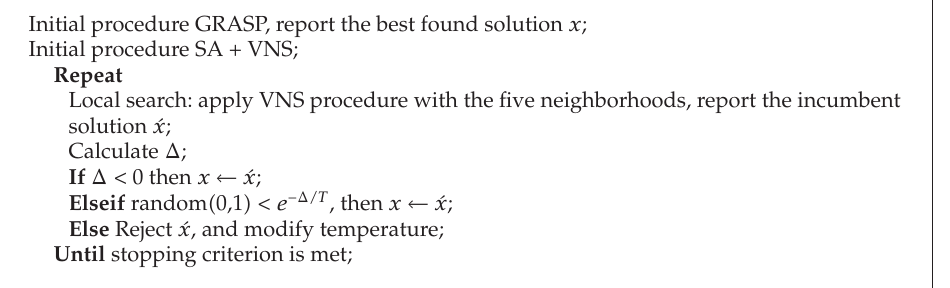
Algorithm 4: The outline of hybrid